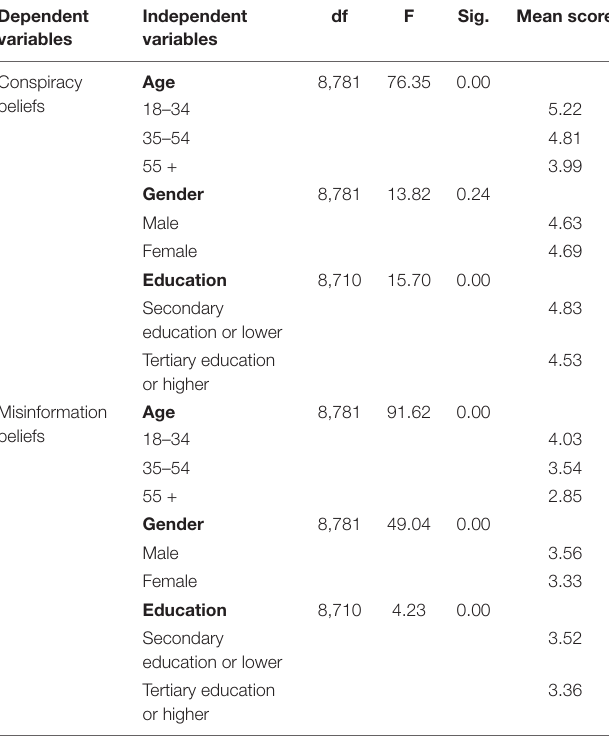
TABLE 4 | One-way ANOVA for age, and independent samples t -test for gender and educational attainment, on conspiracy beliefs and misinformation beliefs. Dependent